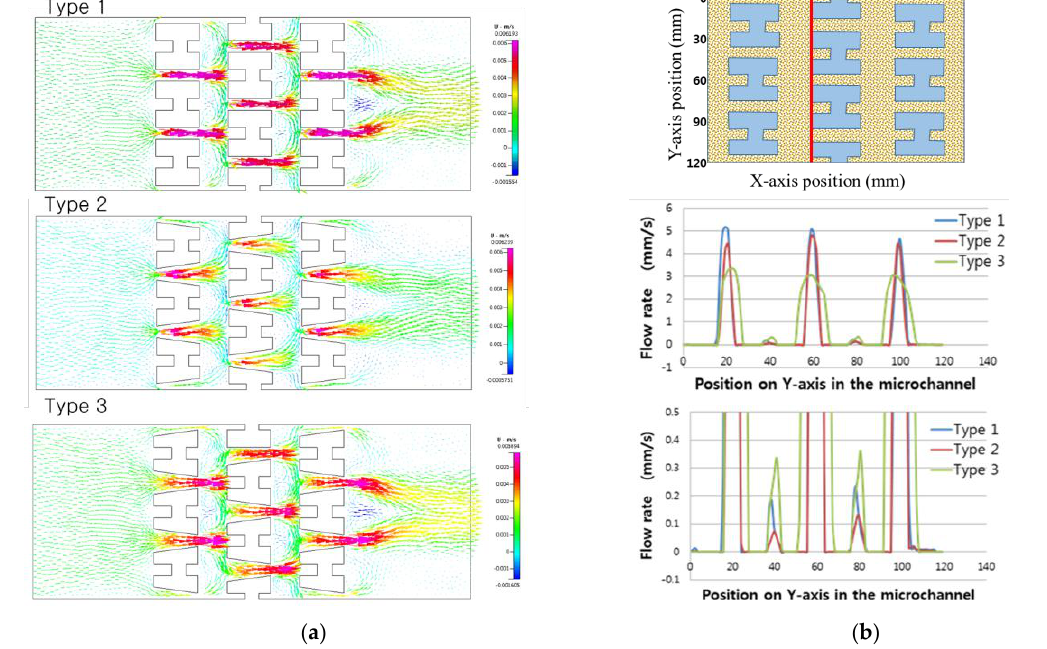
Figure 2. Microfluidic simulation in three different geometries (type 1: rectangle, type 2: right turn trapezoid, and type 3: left turn trapezoid) for capturing the circulating tumor cells (CTCs) using CFD- ACE+ ( a ), and simulation results of local flow rate variation at entrance of the traps along with red line in three different geometries (type 1, type 2, and type 3) ( b